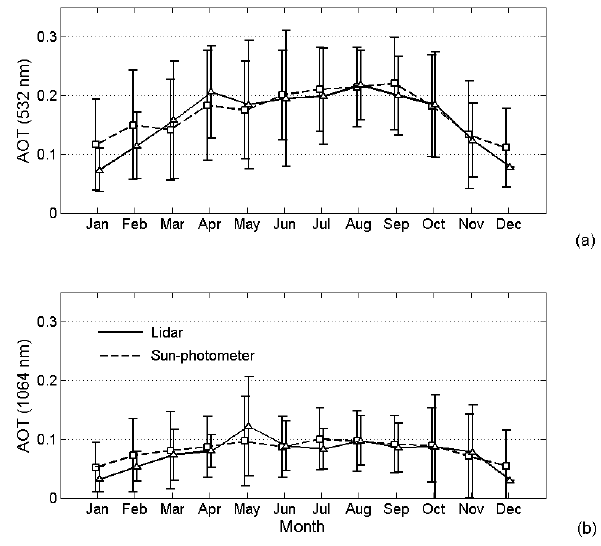
Fig. 2. Annual cycle of the sun-photometer- and lidar-derived AOT (a) at 532nm and (b) at 1064nm. Lidar data are represented by triangles and solid lines. Sun-photometer data are represented by squares and dashes lines. 5